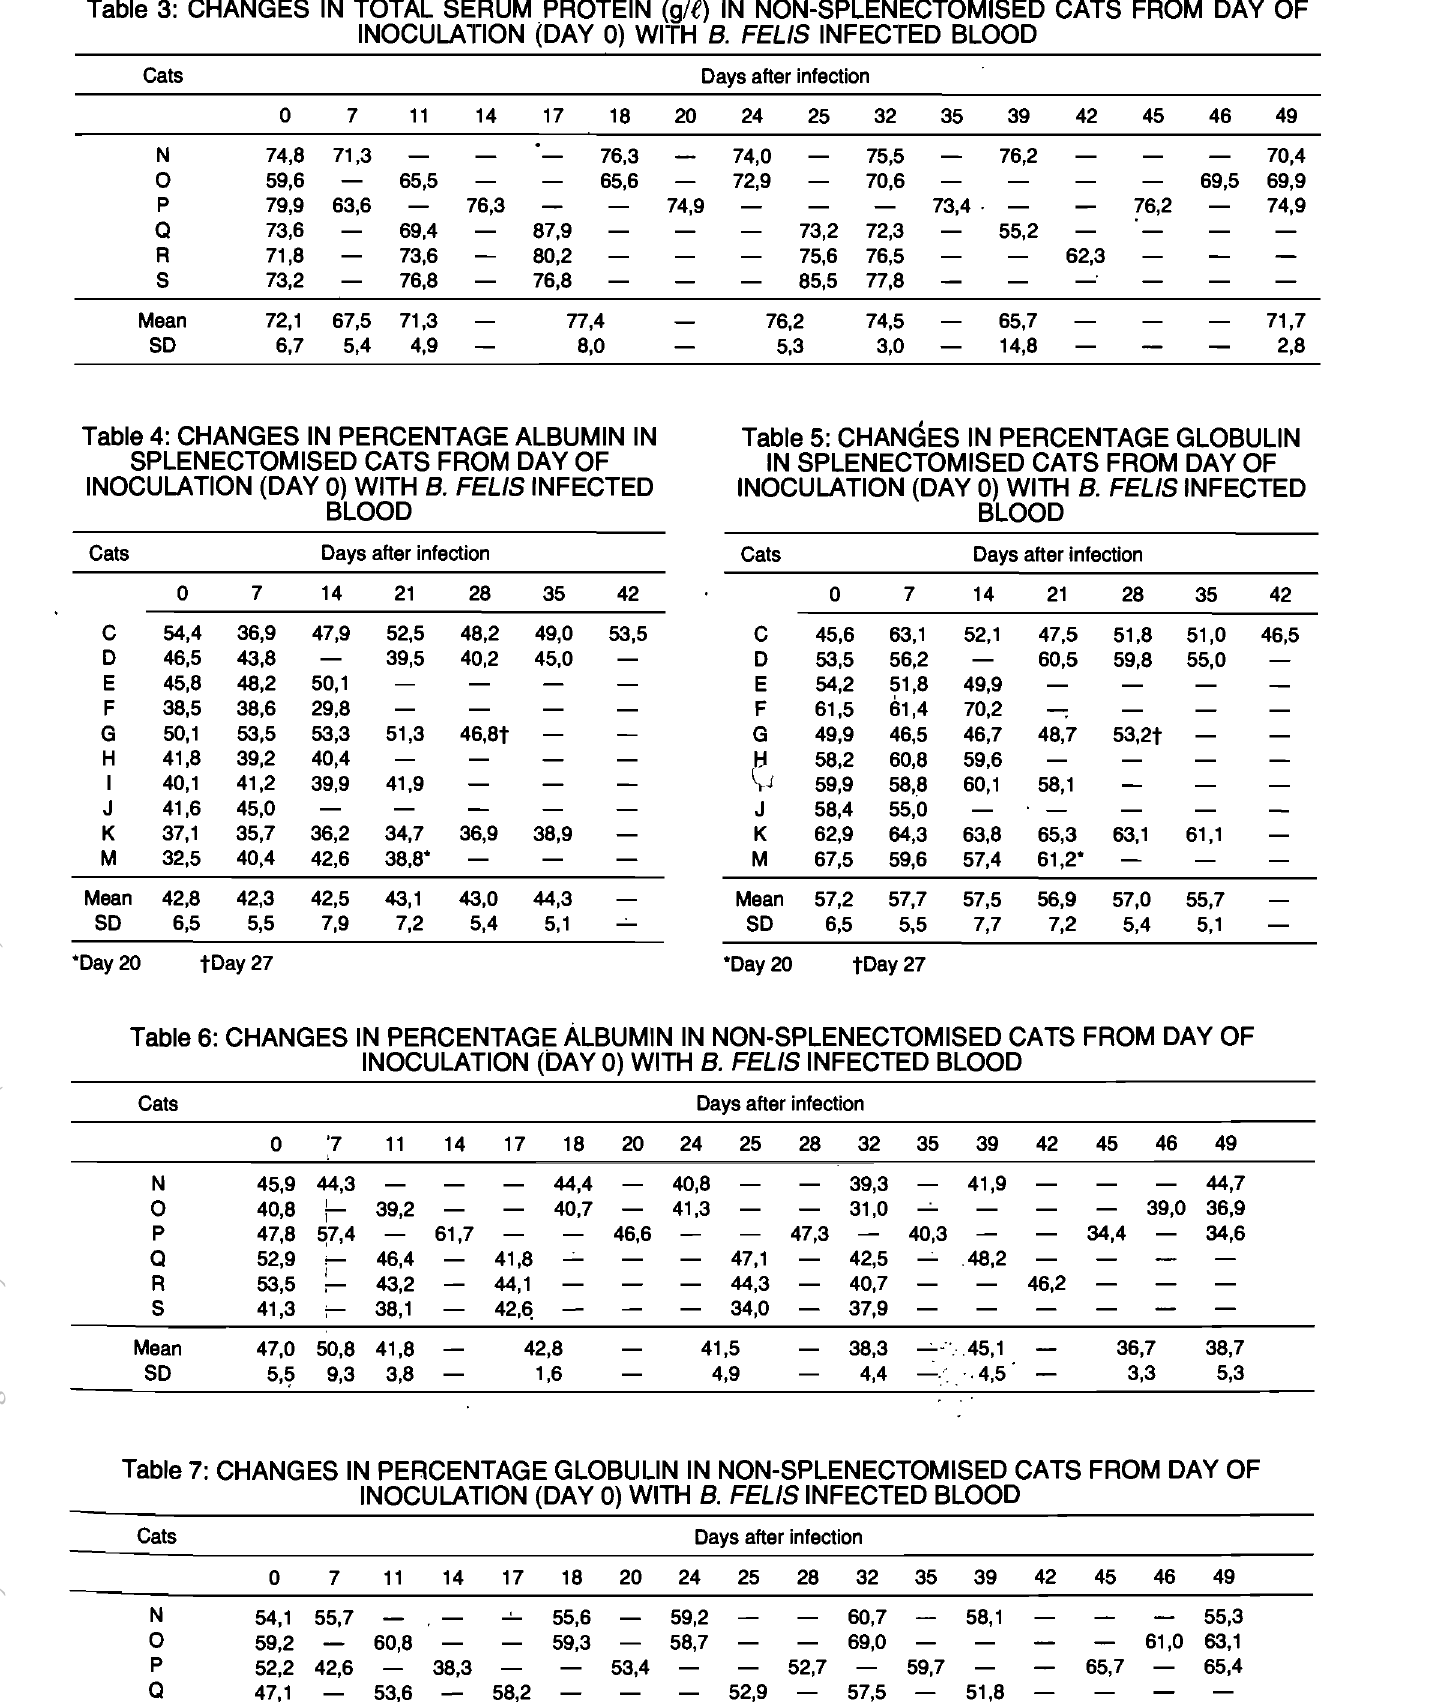
Table 7: CHANGES IN PERCENTAGE GLOBULIN IN NON-SPLENECTOMISED CATS FROM DAY OF INOCULATION (DAY 0) WITH B. FELIS INFECTED BLOOD Cats Days after